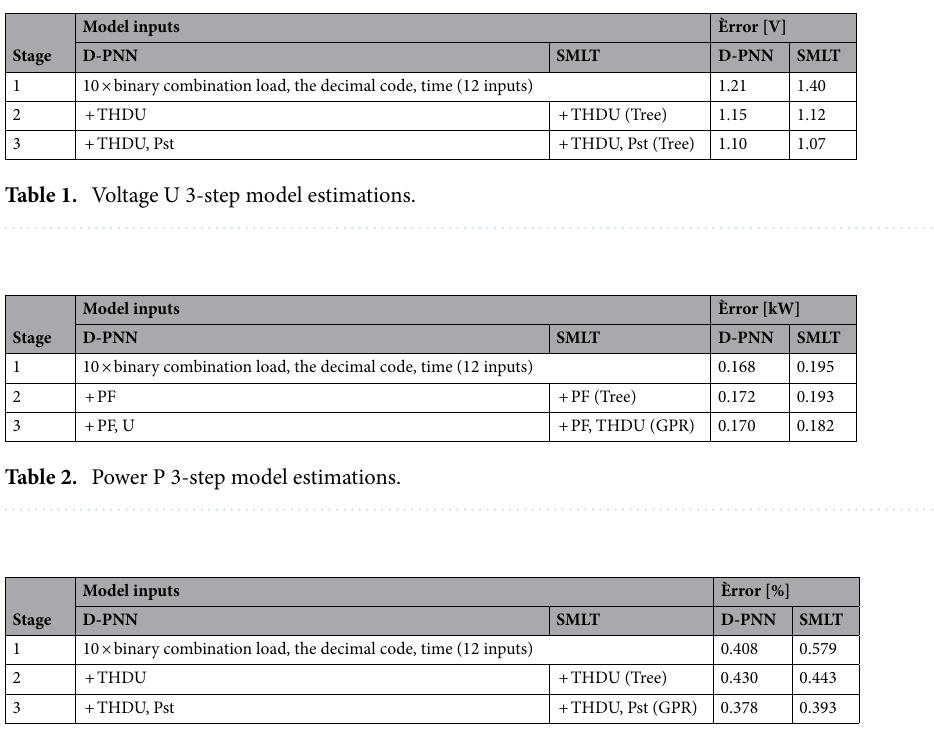
Table 3. THDU 3-step model estimations.